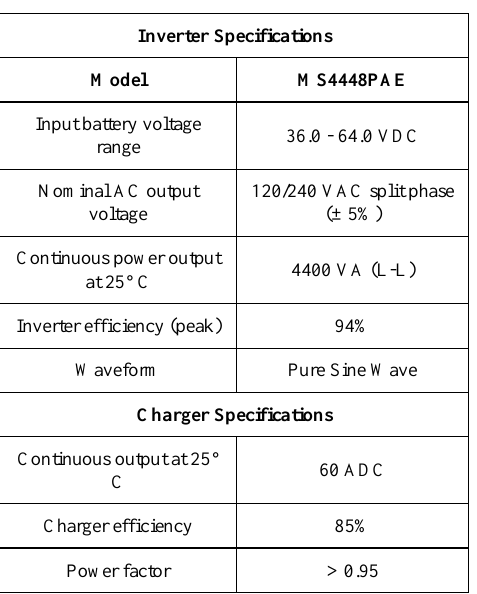
T ABLE 2: T ECHNICAL S PECIFICATIONS OF THE